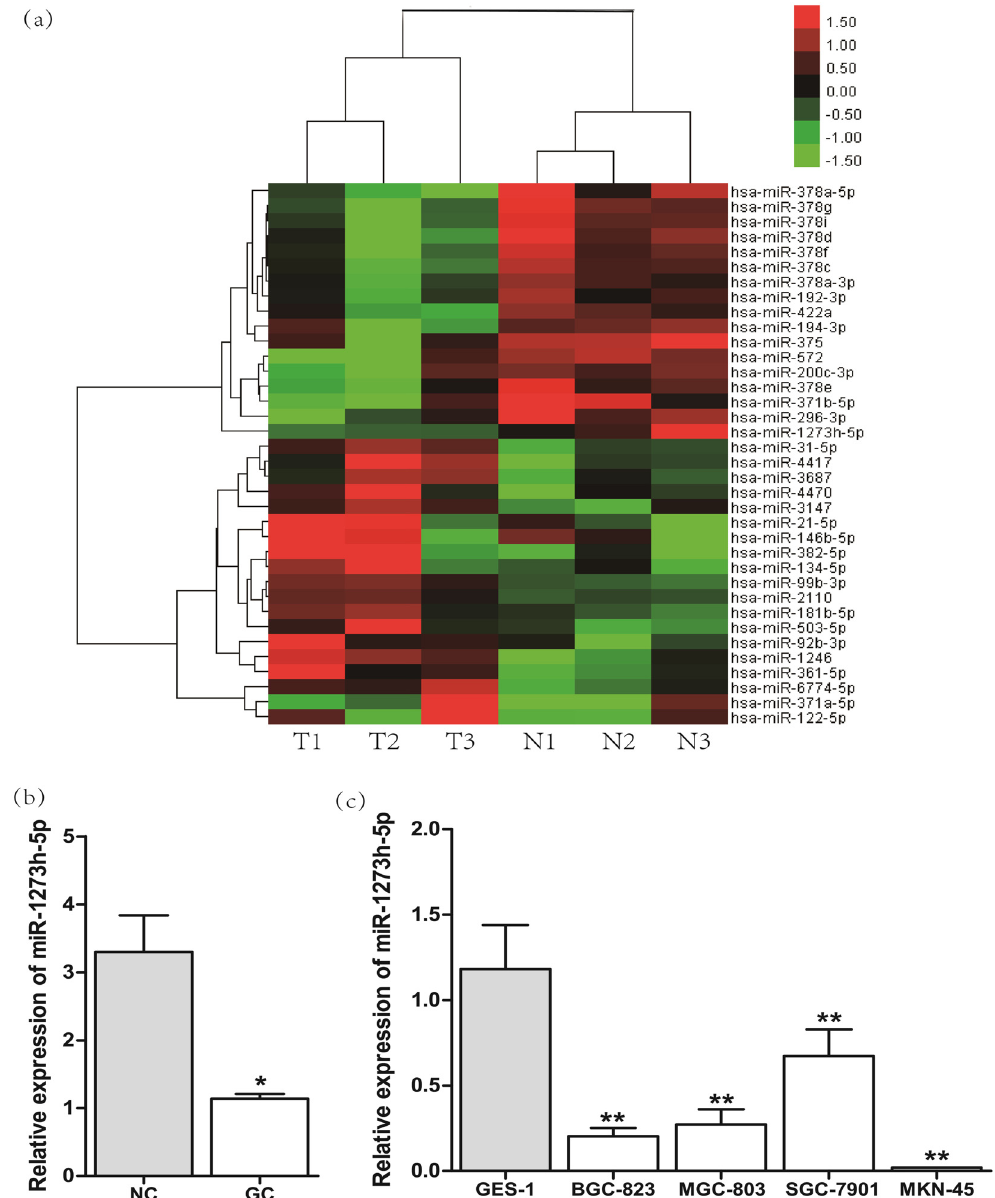
Figure 1: The analysis of di ff erentially expressed miRNAs between GC and tumor - adjacent normal tissues. ( a ) Cluster analysis of di ff er - entially expressed miRNAs between GC and tumor - adjacent normal tissues by microarray assay. Each column indicates a sample, and each row shows the expression level of a gene. The green color indicates low expression, and the red color displays high expression. ( b ) The relative expression of miR - 1273h - 5p in 53 pairs of GC and tumor - adjacent NC was analyzed using RT - PCR. ( c ) The relative expression of miR - 1273h - 5p in GES - 1 and GC cells was determined by RT - PCR. * P < 0.05; compared with GES - 1 cells, * P < 0.05, ** P <